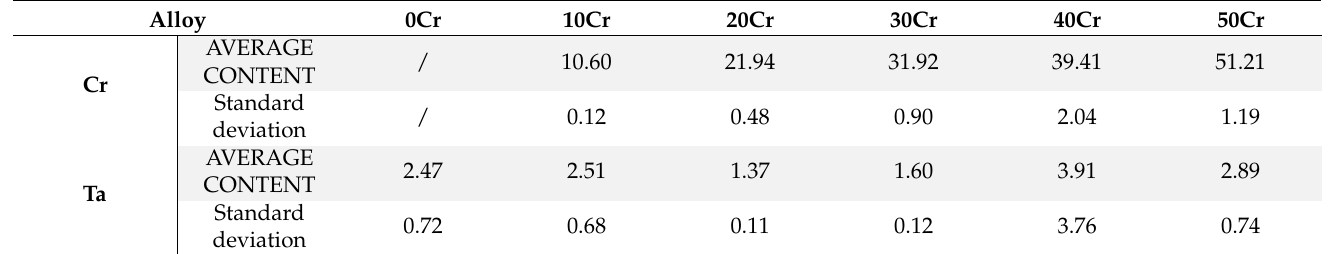
Table 4. Chemical compositions of the matrixes of the aged alloys.